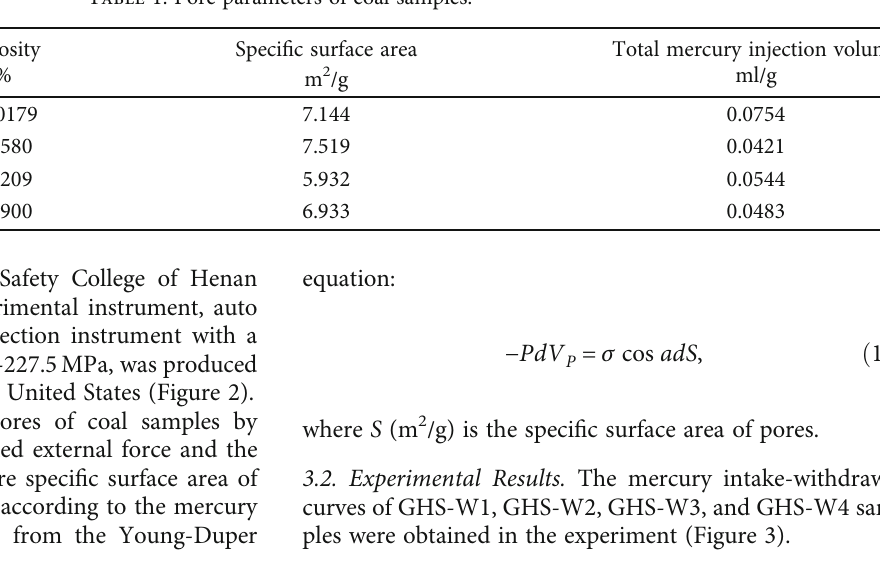
Figure 3: Mercury intake-withdrawal curves of coal samples under di ff erent pressures. Table 1: Pore parameters of coal